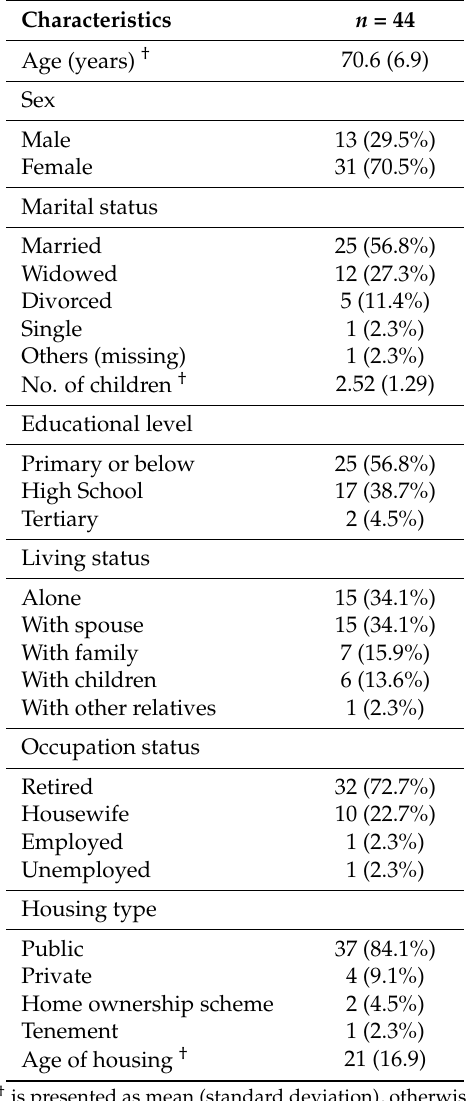
Table 1. Demographic characteristics of